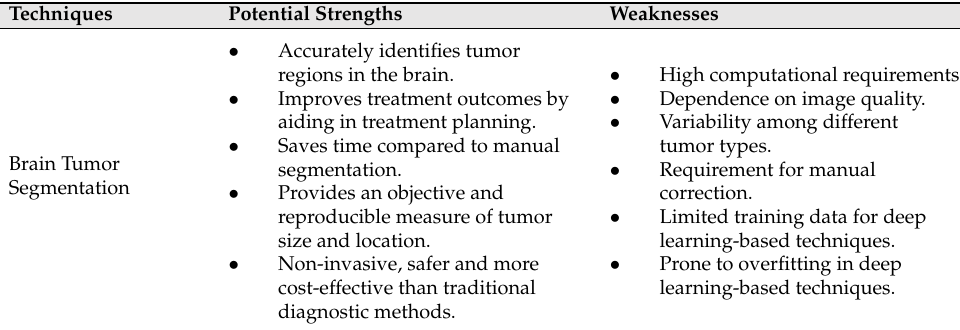
Table 1. Comparative analysis of different brain tumor segmentation